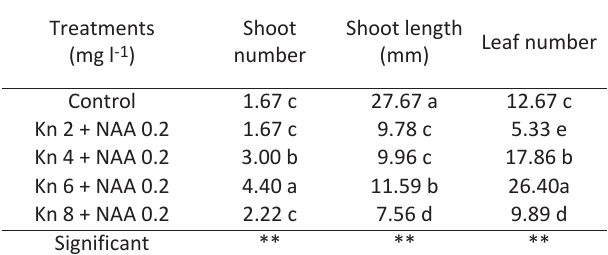
1 - Effects of different treatments of Kn and NAA on shoot number, shoot length and leaf number per explant in ‘Dehdez’ genotype